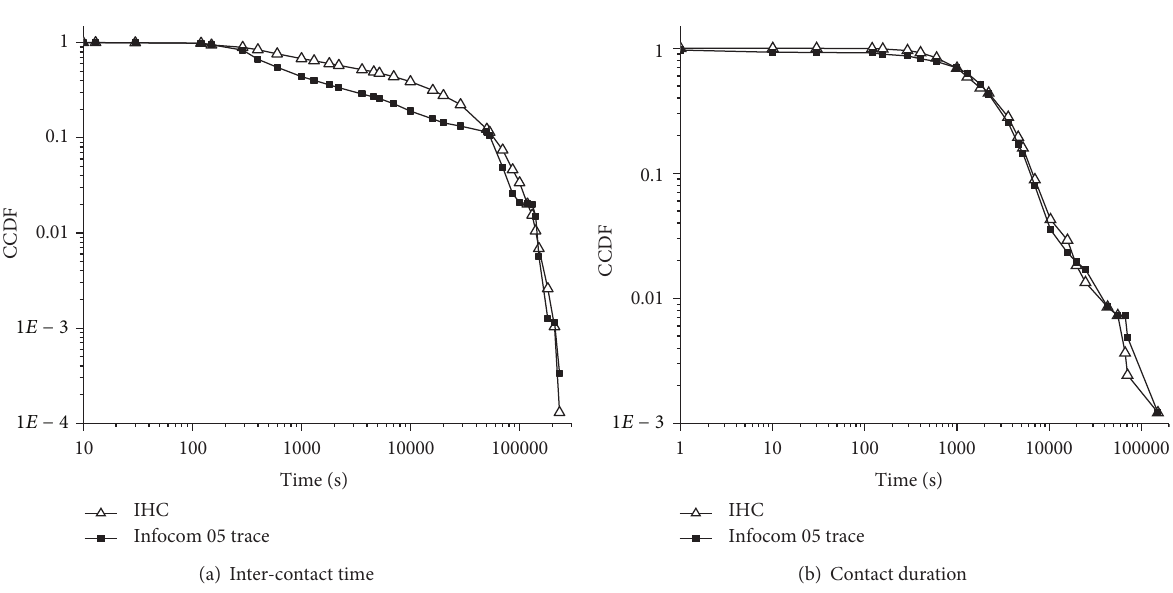
Figure 5: Reproduce Infocom 06 trace using IHC.